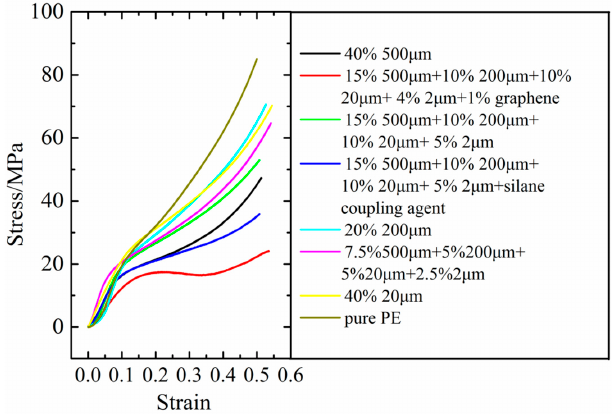
Figure 8. The compression performance curve about the composites.